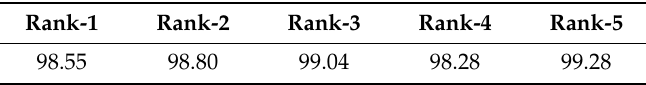
Table 1. The rank- r recognition rates on the UND-J2